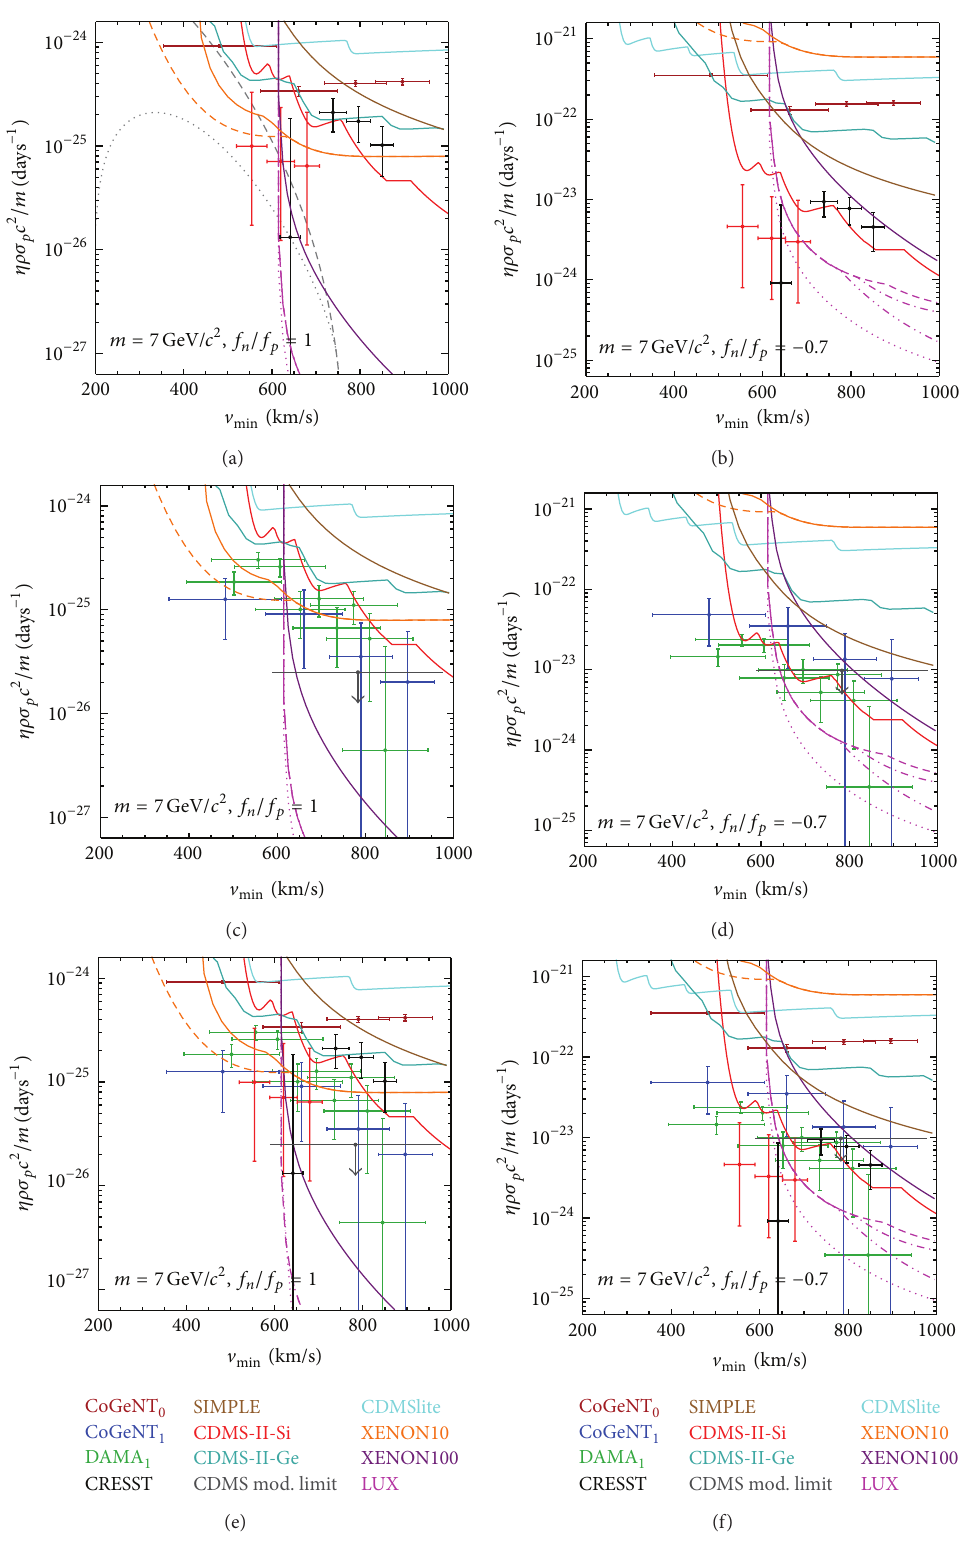
Figure 1: Measurements of and bounds on ̃𝜂 0 𝑐 2 and ̃𝜂 1 𝑐 2 for 𝑚 = 7 GeV/ 𝑐 2 . The left and right columns are for isospin-conserving and isospin-violating interactions, respectively. The dashed gray lines in the top left panel show the SHM ̃𝜂 0 𝑐 2 and ̃𝜂 1 𝑐 2 for 𝜎 𝑝 = 10 −40 cm 2 (see